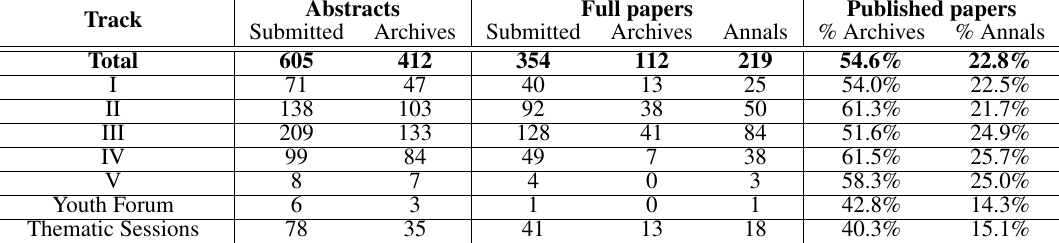
Table 2. Detailed statistics for each